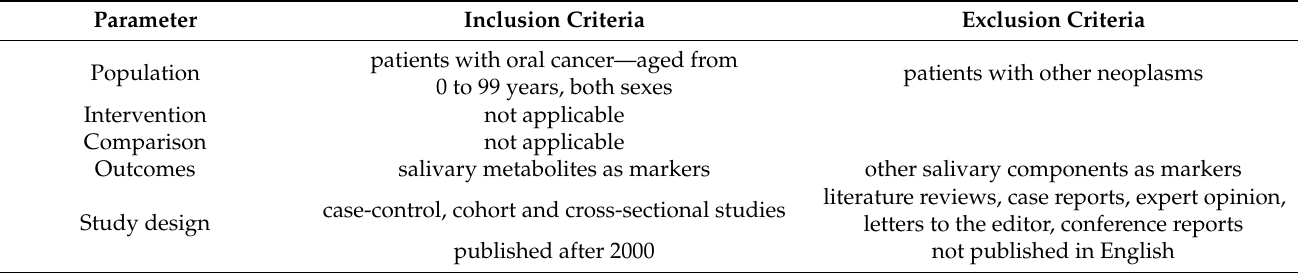
Table 4. Inclusion and exclusion criteria according to the